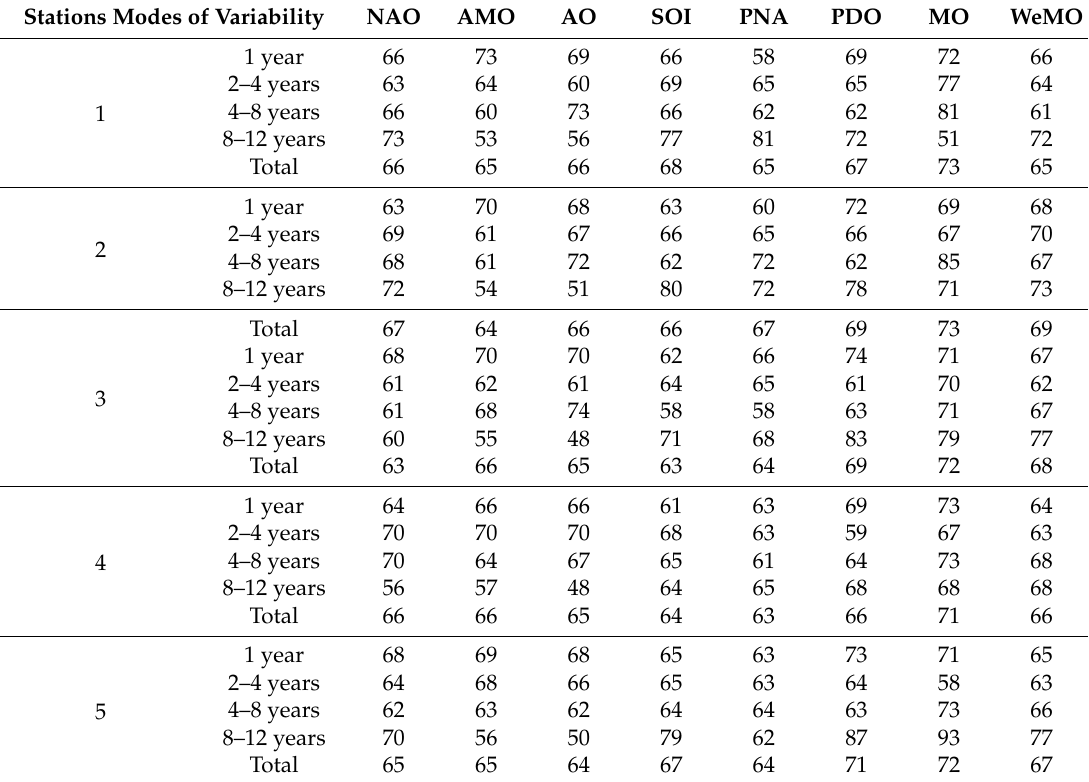
Table 2. Mean contribution of climate indices/precipitation wavelet coherence at different modes of variability at the stations in Gabes